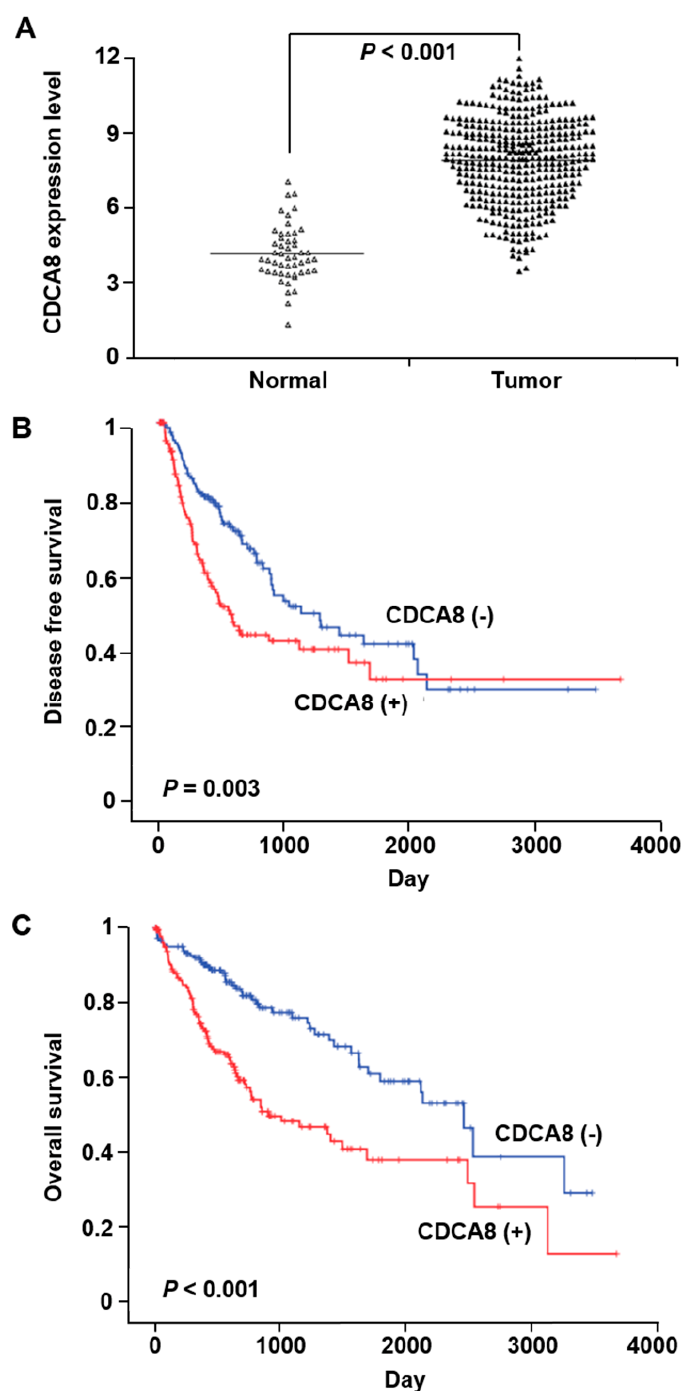
Figure 1. The correlation between CDCA8 overexpression and prognosis in hepatocellular carcinoma (HCC) patients. ( A ) Upregulation of CDCA8 in HCC tissues compared to that in adjacent noncancerous tissues ( p < 0.001). ( B , C ) Associations between CDCA8 expression and the patient’s disease-free survival ( p = 0.003) ( B ) and overall survival ( p < 0.001) ( C ).